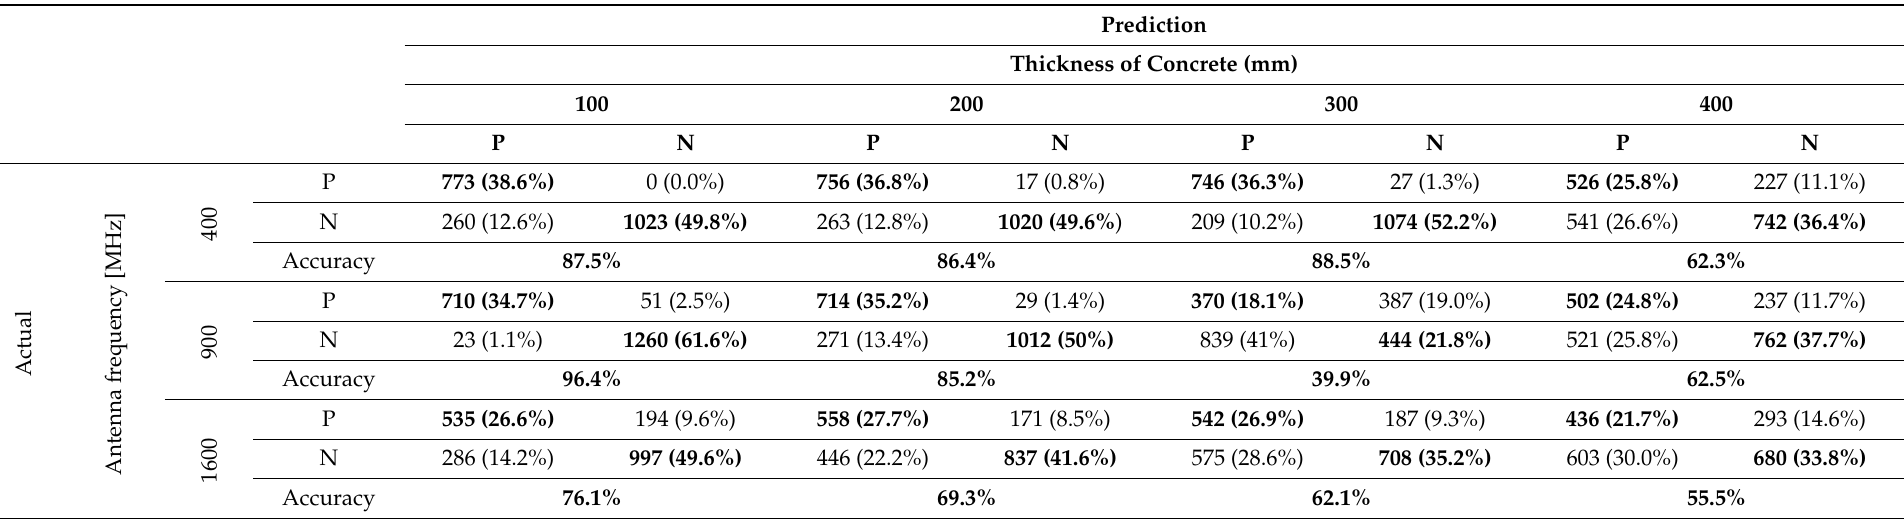
Table 3. Confusion matrix for classification based on cross-correlation coefficient of GPR